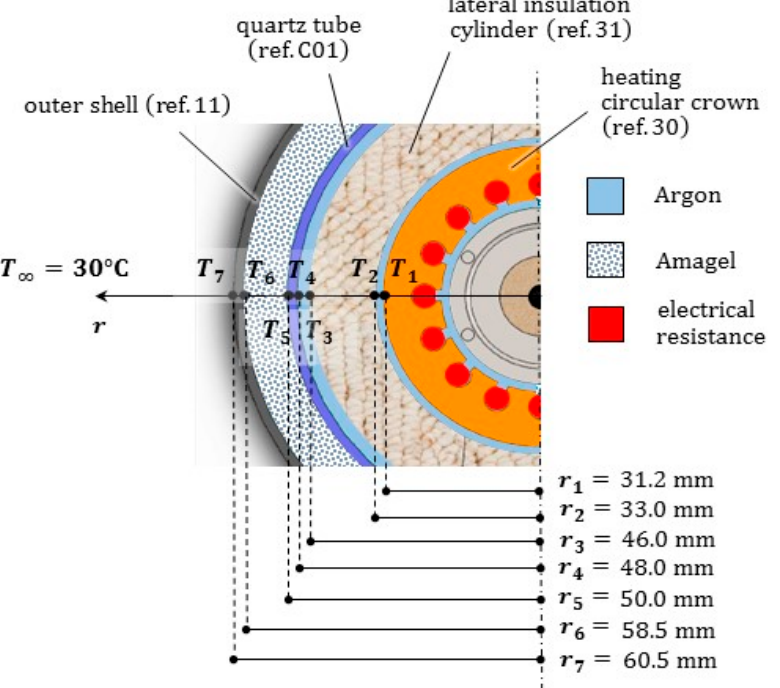
Figure 11. Top view of the coaxial material layers and of the gas filled cavities constituting the furnace, with the relevant size. Temperatures at each layer are indicated, to be computed by the thermal resistance network assuming a radial heat transfer mechanism.